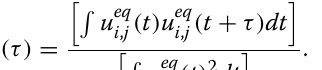
trace was denoted as u